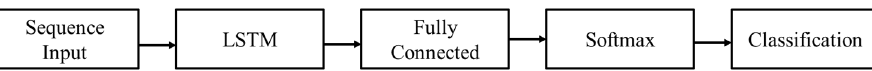
Figure 7. The architecture of LSTM layer. This diagram presents the flow of the time-series data (x,y) with features (channels) C of length S through an LSTM layer. In the diagram, ℎ (cid:3047) and 𝑐 (cid:3047) denote the output or the hidden state and the cell state, respectively. ML + DL Approach: The combination of two ML + DL approaches is also considered to classify the driver’s cognitive load, which are CNN + SVM and AE + SVM. CNN + SVM: A DL + ML approach considering CNN + SVM is presented in Figure 8. The CNN model presented in Figure 8 is used to extract features automatically from the raw data and the features are then used for cognitive load classification using a machine learning classifier. Figure 8. The block diagram of ML + DL approach using CNN + SVM for cognitive load classifica- tion.